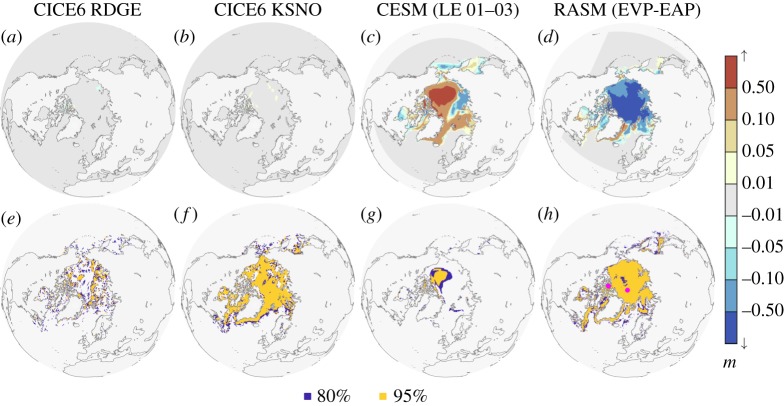
2000–2004 mean 0000 UTC daily sea-ice thickness difference  for the (a) RDGE and (b) KSNO simulations when compared with the baseline CICE6 simulation, while (c) compares CESM Large Ensemble members 01 and 03, and (d) provides the RASM EVP minus EAP comparison. (e–h) Flag regions for which the alternate hypothesis  is true after Stage 2 of the 2SPT test at the 80% (blue) and 95% (amber) two-sided confidence intervals. Magenta markers in (h) indicate the location of the North Pole and Bathurst Island coastal time series in figure 3. Grey shading in (a–d) indicates the extent of the analysed domain for each respective model.